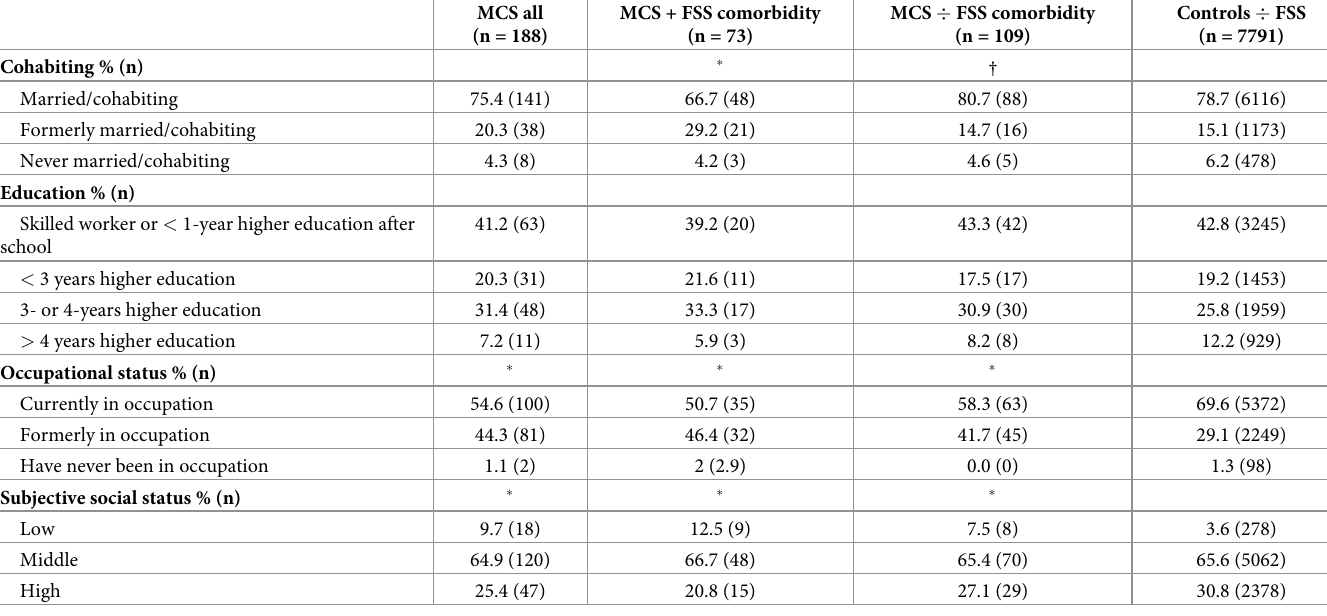
Table 2. Socioeconomic status of participants meeting criteria for multiple chemical sensitivity (MCS) and of controls not meeting the criteria for any of five func- tional somatic syndromes